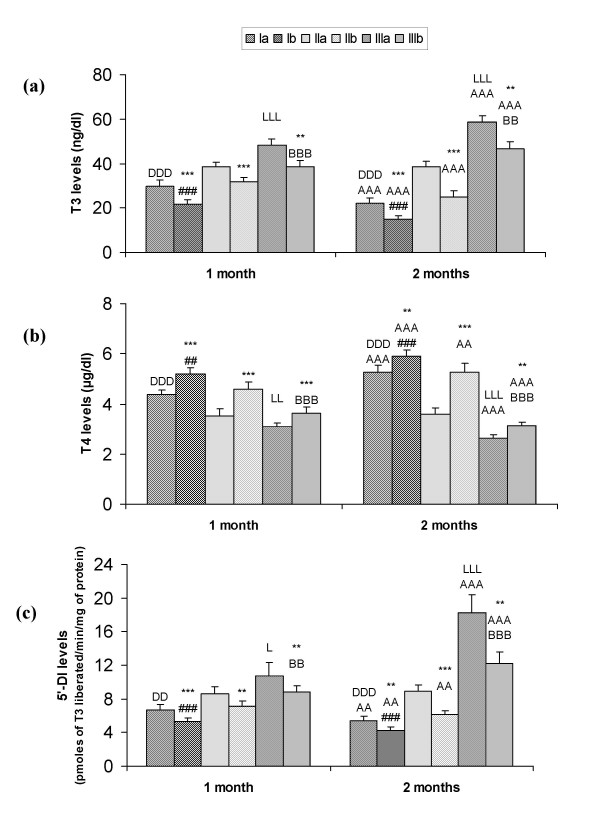
T3 (a), T4 (b) and 5'-DI (c) levels in serum in different groups: Ia-Se deficient control, Ib-Se deficient+HCD, IIa-Se adequate control, IIb-Se adequate+HCD, IIIa-Se excess control, IIIb-Se excess+HCD after 1 and 2 months. Data is represented as mean ± SD from 6 observations. **p<0.01, ***p<0.001 represent comparison between control and HCD groups; AAp<0.01, AAAp<0.001 comparison between 1 and 2 months; DDp<0.01, DDDp<0.001 comparison between group Ia and IIa; ##p<0.01, ###p<0.001 comparison between group Ib and IIb; Lp<0.05, LLp<0.01, LLLp<0.001 comparison between group IIa and IIIa; BBp<0.01, BBBp<0.001 comparison between group IIb and IIIb.